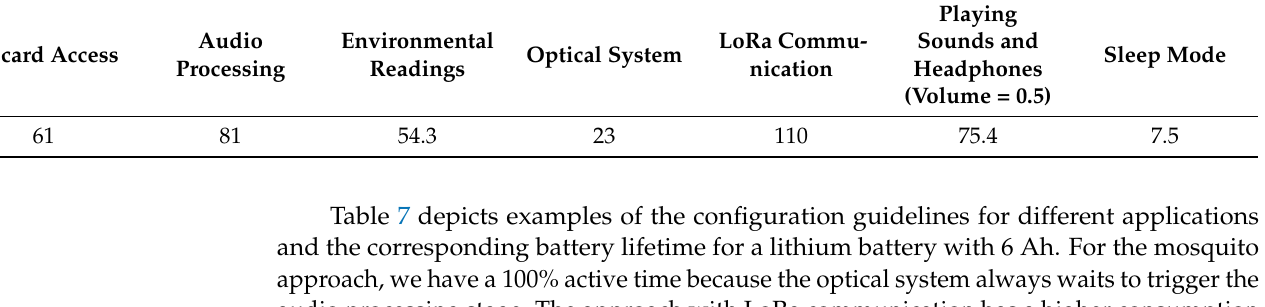
Table 6. Power consumption in mA for a lithium-ion battery with 6